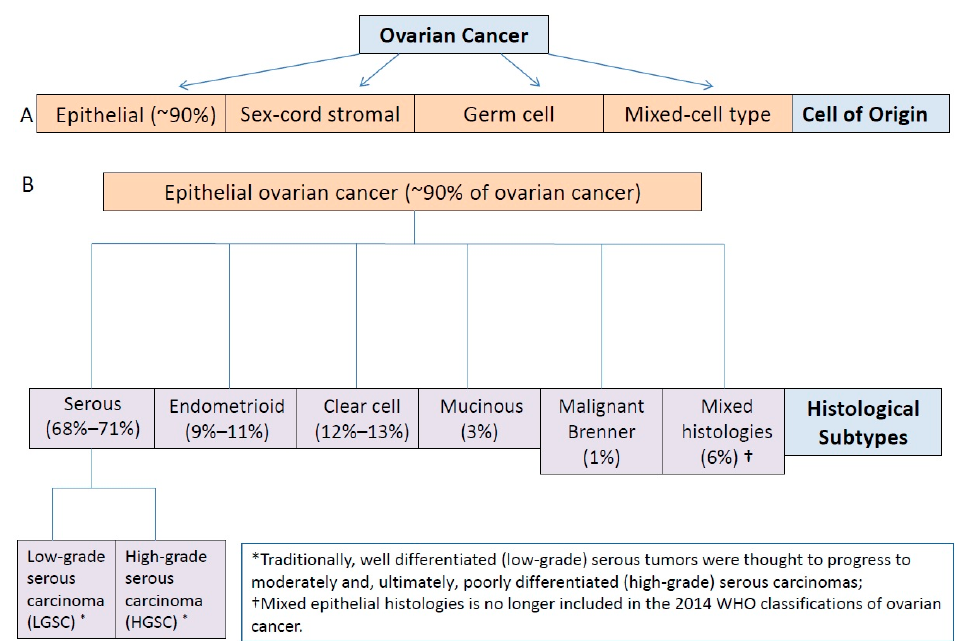
Figure 1. ( A ) Histological subtypes of ovarian cancer; and ( B ) traditional epithelial ovarian cancer classification paradigm based on tumor histology and grade (prevalence of histological subtypes from: McCluggage et al. [8]).